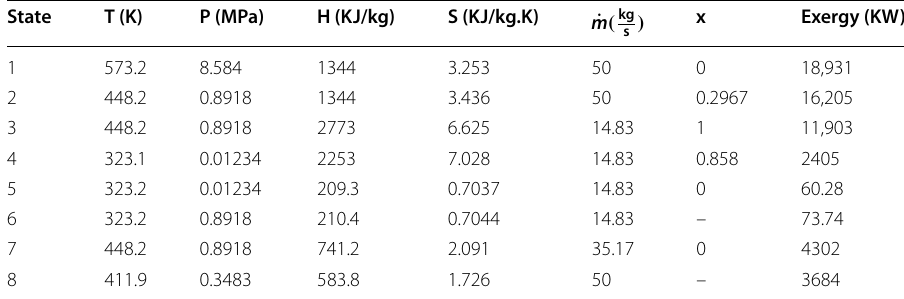
Table 5 Single flash geothermal cycle’s thermodynamic data State